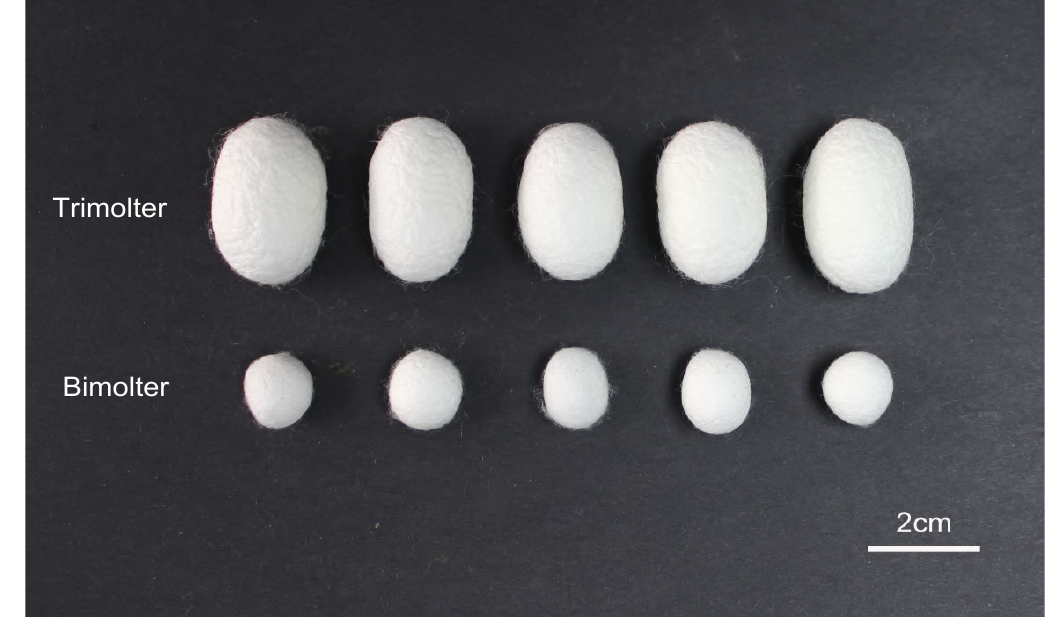
Figure 2. Photos of cocoons from the trimolter and bimolter. Bars represent 2